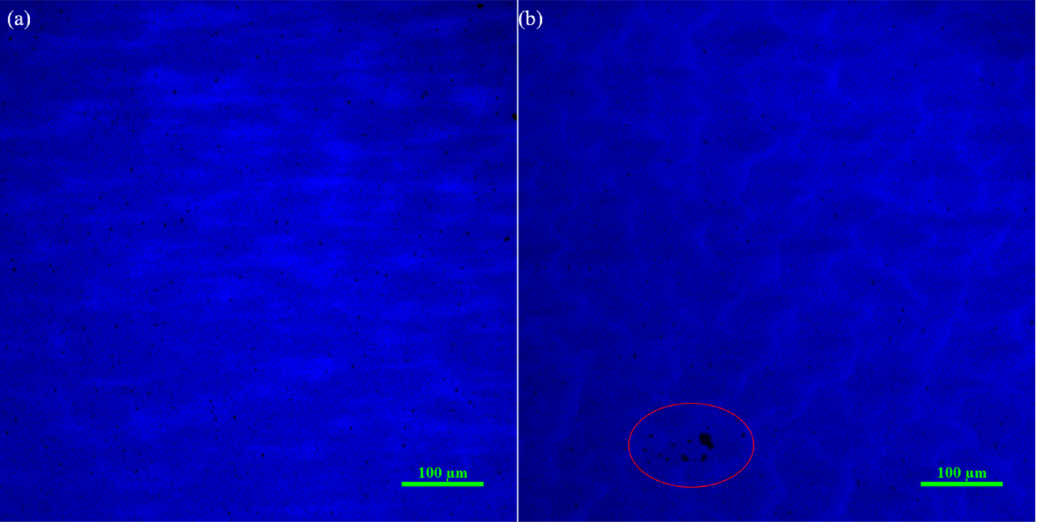
Figure 6. The micro-PL images of GaN-based MQW samples 2QW ( a ) and 2QW-EBL ( b ); the huge black spots shown in the red circle may correspond to the new kind of non-radiative recombination